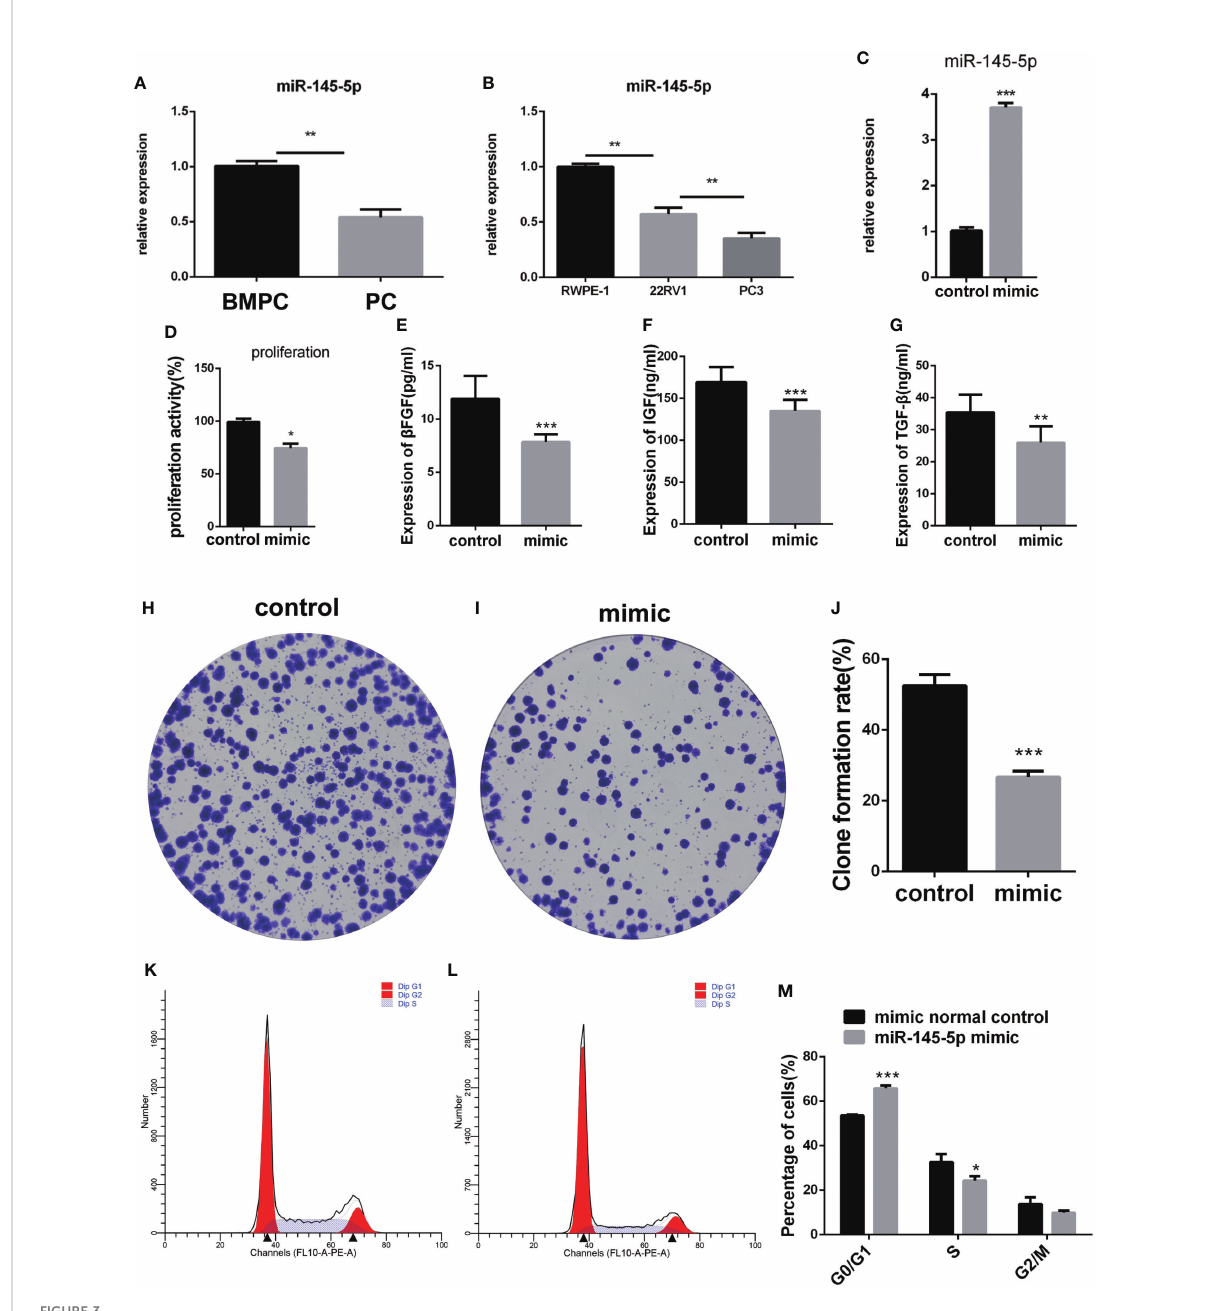
FIGURE 3 miRNA-145-5p inhibited proliferation of bone metastatic Pca cells, PC-3. (A) RT-qPCR data for miRNA-145-5p expression in Pca bone metastases. (B) RT-qPCR data for miRNA-145-5p expression in PC3, 22RV1 and RWPE-1 cell lines. (C) miRNA-145-5p expression after